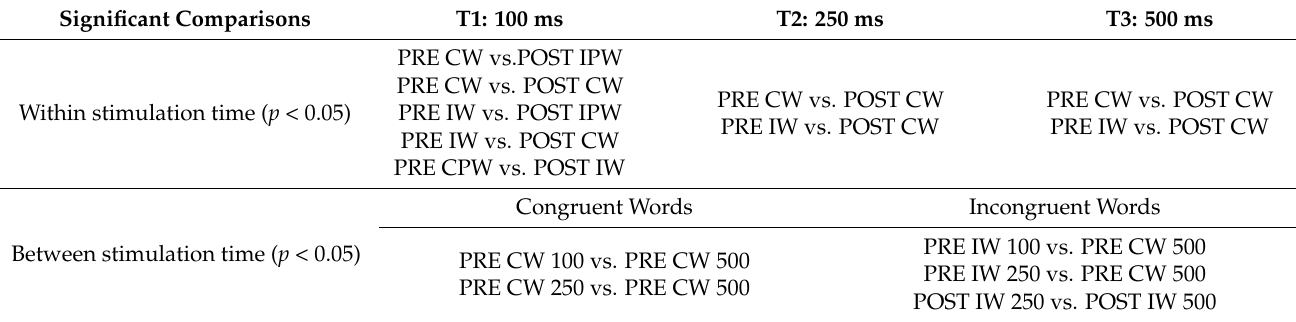
Table 2. A summary of the results of post-hoc analysis carried out after the three factor interaction ANOVA (TRAINING × SEMANTICS × STIMULATION DELAY) on normalized FDI MEPs ampli- tudes. PRE and POST labels indicate pre and post-training phases. The upper side of the table shows the significant comparisons that emerged considering the differences between conditions at each stimulation delay. The lower side shows the significant comparisons that emerged considering the differences between the same stimuli at different stimulation delays. CW: Congruent Words;